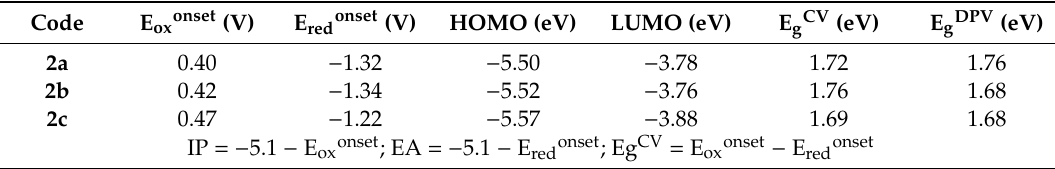
Table 1. Electrochemical data for phenothiazine derivatives 2a–2c measured in 0.1M Bu 4 NPF 6 / CH 2 Cl 2 solution.